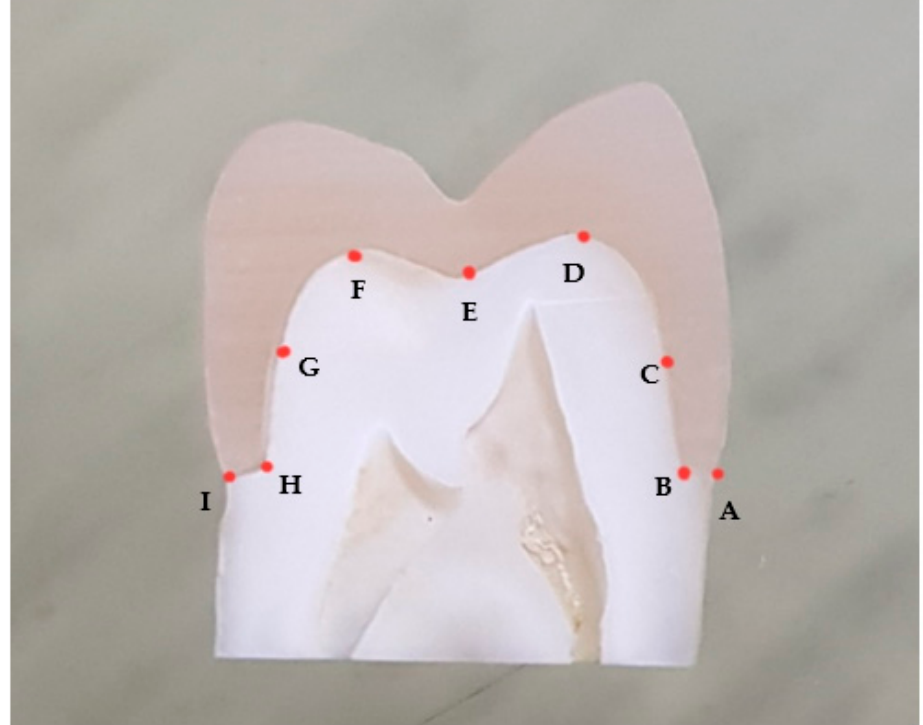
Figure 2. Points of measurement of marginal and internal fit; ( A ) buccal margin, ( B ) buccal chamber finish line, ( C ) mid-buccal axial wall, ( D ) Buccal cusp tip, ( E ) central groove, ( F ) palatal cusp tip, ( G ) mid-palatal axial wall, ( H ) palatal chamfer finish line, ( I ) palatal margin. Data were analyzed a software (SPSS V 22.0, IBM SPSS corp., Armonk, NY, USA).